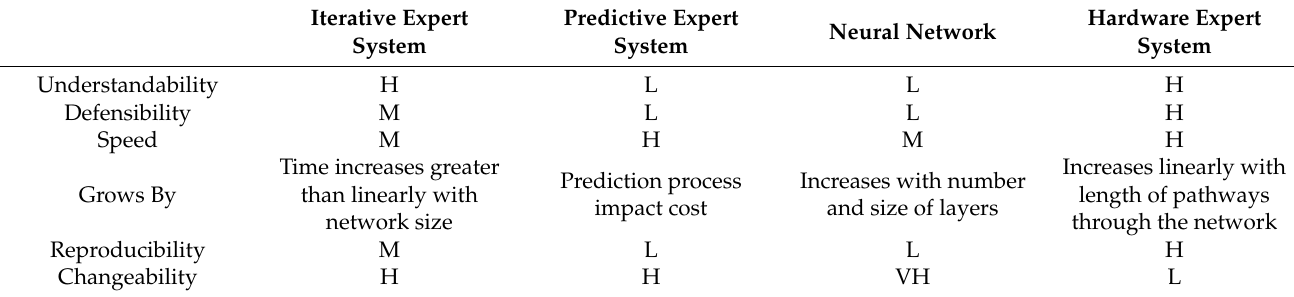
Table 8. Comparison to other state-of-the-art